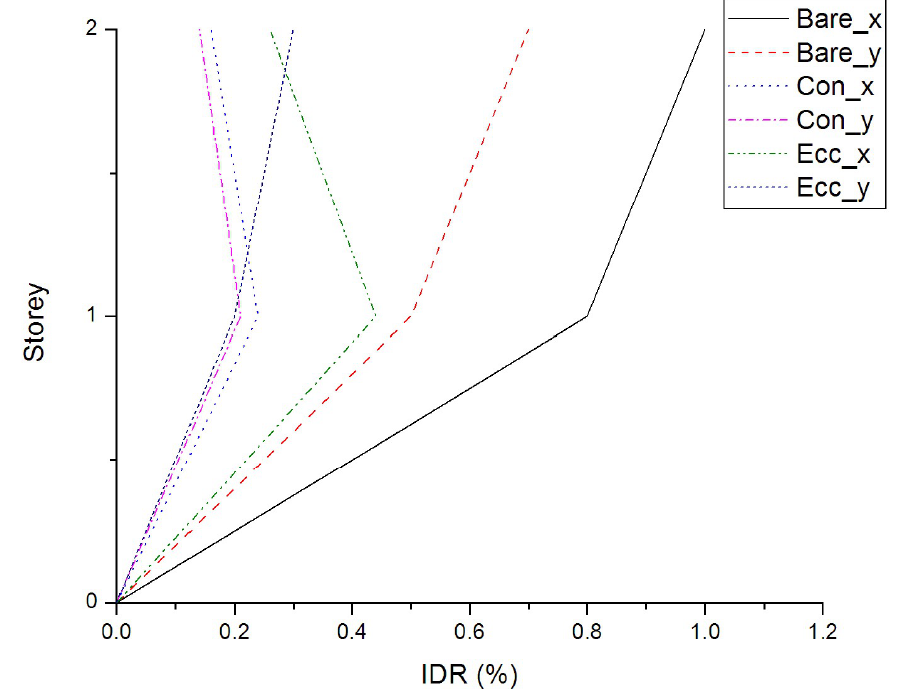
Figure 4. Distribution of peak IDR for the RC building with and without the seesaw system, when subjected to seismic motion No. 4 of Table 3.